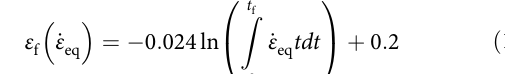
revealed between the monotonic ε Fig. 2d and the integration of strain history, ε time: